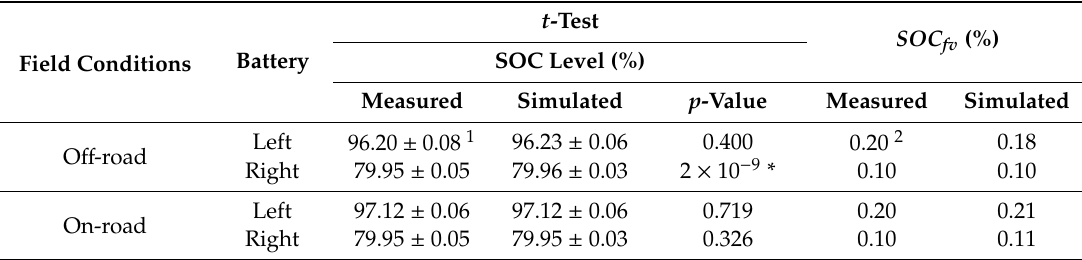
Table 3. Comparison of SOC level and final variation in SOC ( SOC fv ) between measured and simulated result based on the operation conditions at 10 km /